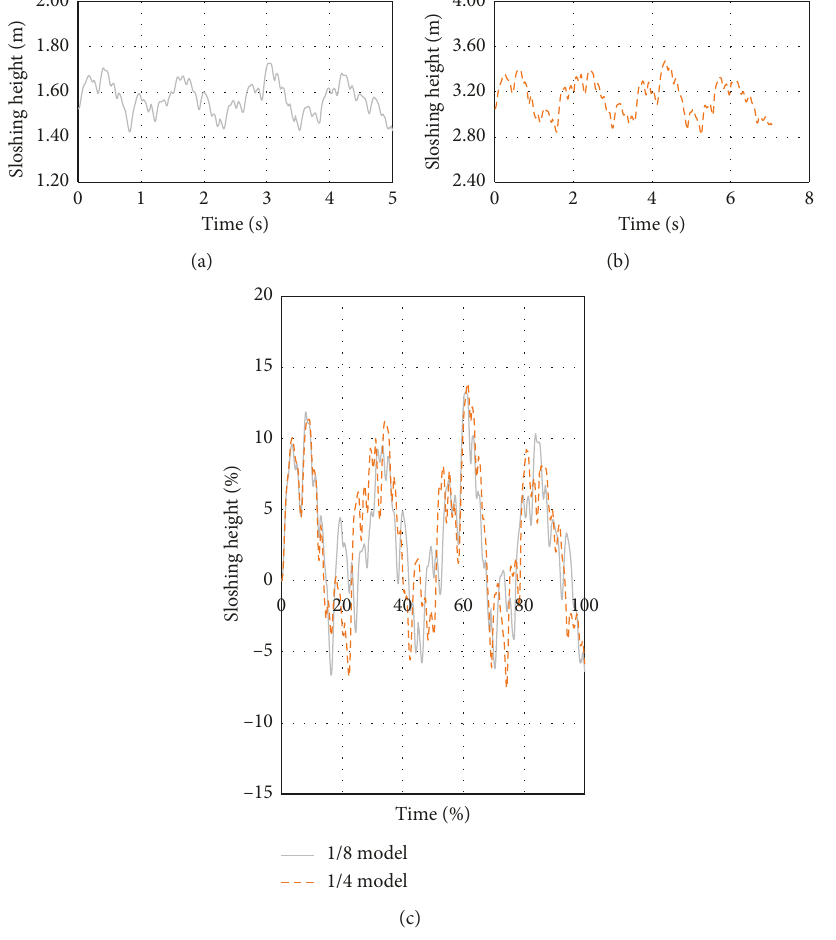
Figure 5: Sloshing heights in (a) 1/8 model and (b). 1/4 model. (c) Comparison of sloshing heights under high-frequency